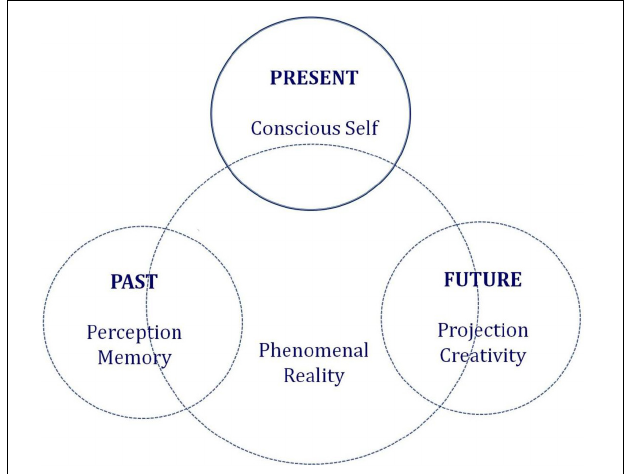
FIGURE 1 | All phenomenal reality originates from the ontological link between time and consciousness (after Dresp-Langley and Durup, 2012). This leads to consider consciousness as a form of creative energy beyond space and time, where specific cognitive abilities such as perception, memory or projective thinking and reasoning, although they may exploit conscious energy, need to be placed at a separate ontological level. An optimally expanded level of consciousness (by deep meditation or other mindfulness practice) would be equivalent to an expanded Self in a state of deep of sense of present, past, and future at one and the same moment in time. Such deep states of consciousness may not be attainable by our species.